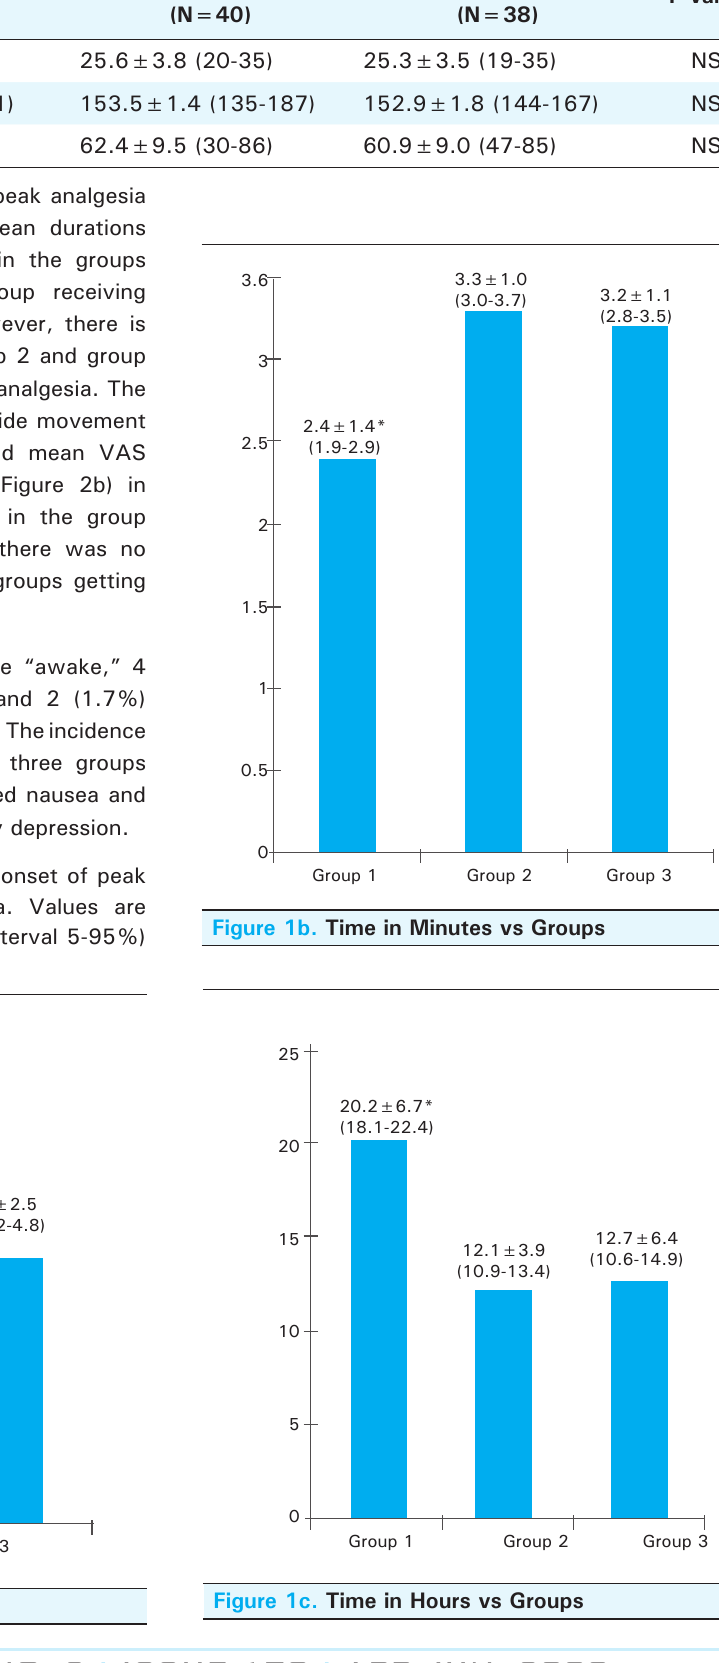
Downloaded from